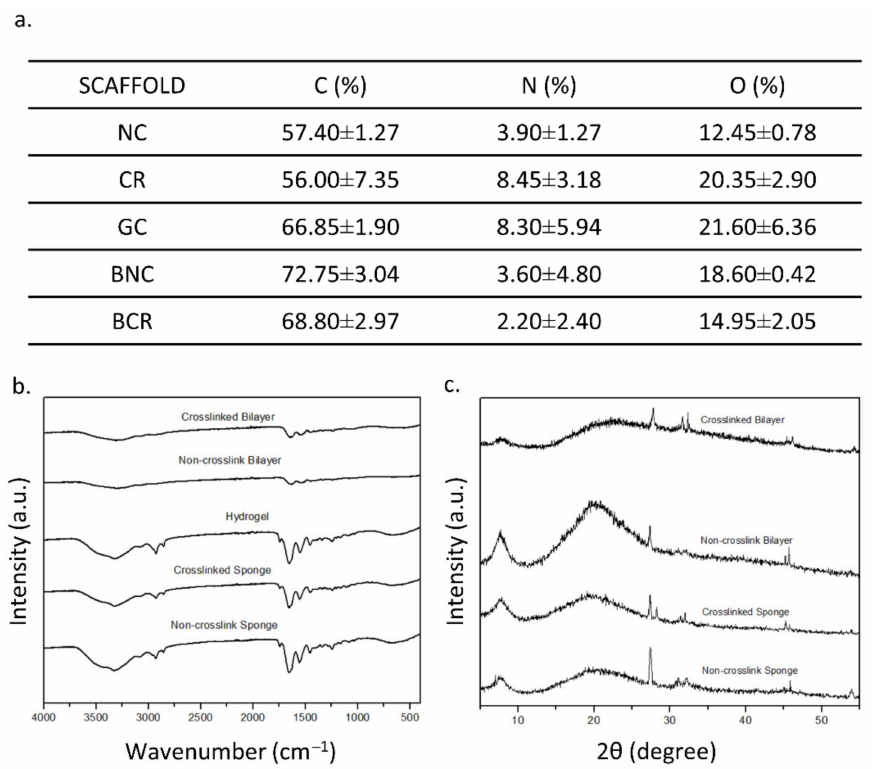
Figure 5. The chemical characteristics of the scaffolds at room temperature. ( a ) The EDX results, ( b ) FTIR results, and ( c ) XRD results of the scaffolds. * p < 0.05 indicates the siginificant differences of the fabricated